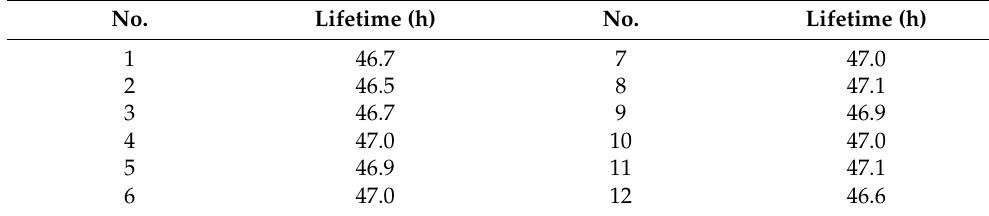
Table 7. Results of the WSND lifetime measured under actual UHVDC transmission lines.